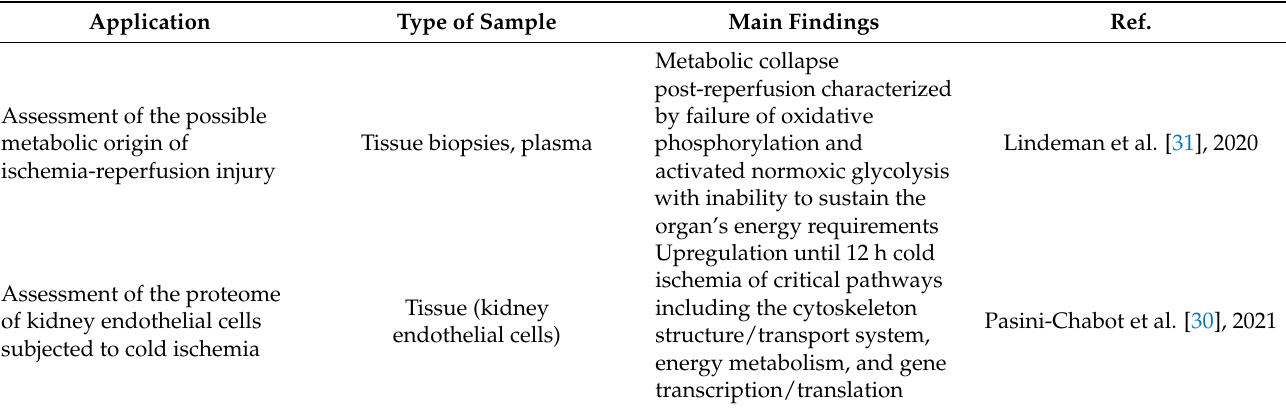
Table 2. Recent proteomic studies on ischemia-reperfusion injury in the setting of kidney transplantation. Application Type of Sample Main Findings